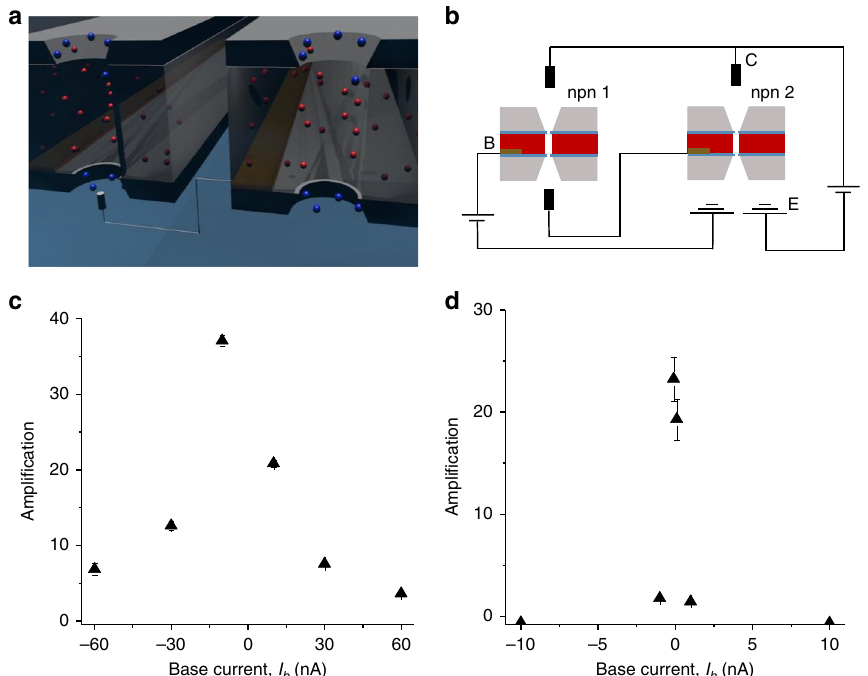
Fig. 5 Ampli fi cation performance of an ionic Darlington circuit. a , b Darlington ampli fi er circuit scheme and setup, respectively. c Current gain as a function of base current, I b , for two bipolar transistors connected in a Darlington ampli fi er circuit in 1 mM KCl. Devices had pore sizes of 540 nm and 520 nm. d Current gain for a Darlington circuit composed of two bipolar transistors that contained pores with diameter of 140 nm and 150 nm; measurements were taken in 100 mM KCl. Error bars were calculated as standard deviation from an average of values in at least two voltage